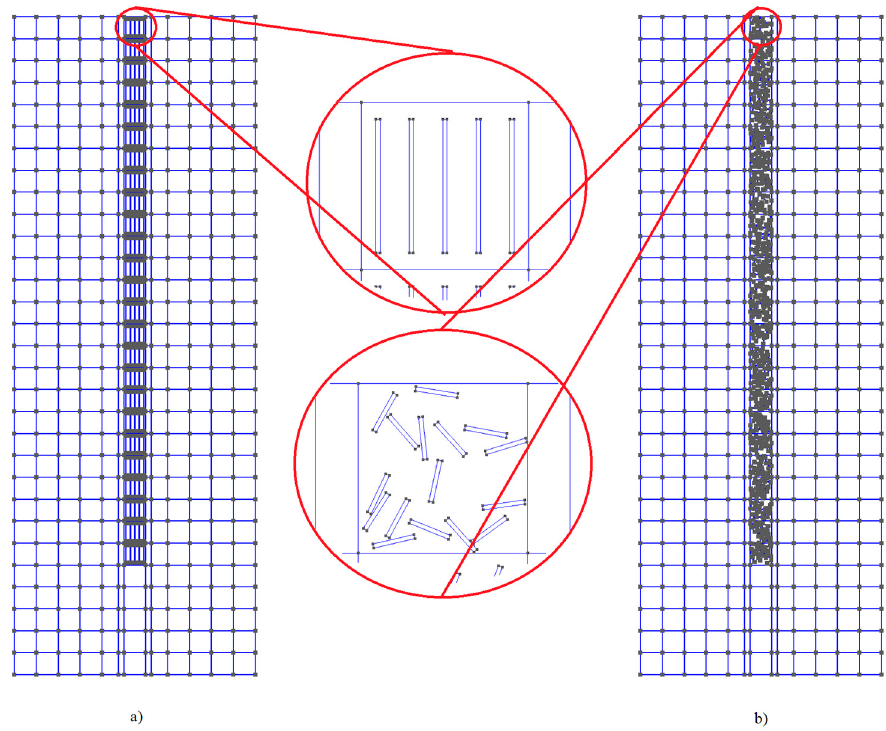
Figure 2. Computational domain ( a ) is structured, ( b ) is randomized.